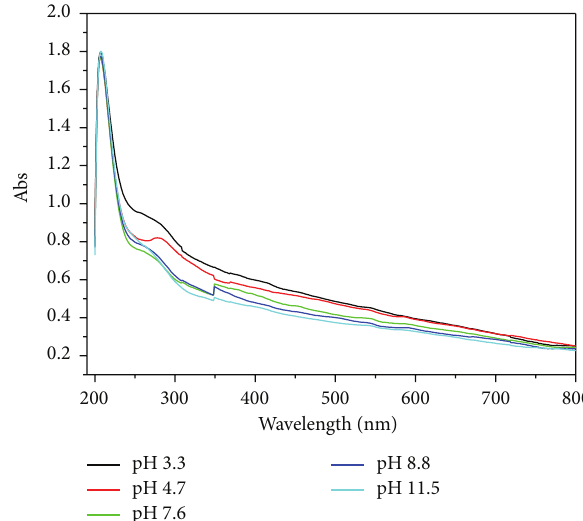
Figure 1: Nitrate-nitrogen (NO 3 − -N) concentrations in PVA (squares) and PE (circle) as a function of operation time. Figure 2: Absorption (Abs) spectra of activated sludge suspensions at different pH